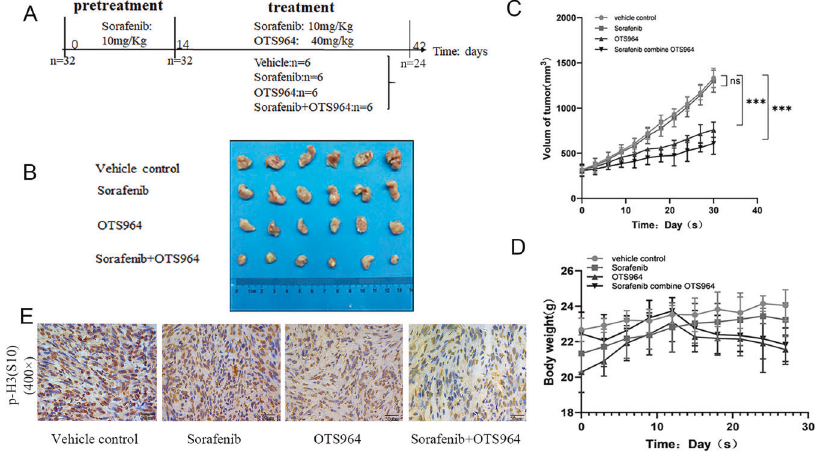
Fig. 6 TOPK inhibitor combined with sorafenib suppresses the tumor of sorafenib-resistant RCC. A The schedule of animal experiment in the present study was drawn up. B The collected tumors were photographed. C The grow curves of tumors in different groups were visualized. D The bodyweights of mice, ‘ ** ’ ( P < 0.001) showed a signi fi cant difference. E Representative IHC images (×400) of phosphorylated H3 (p-H3) in different treatment